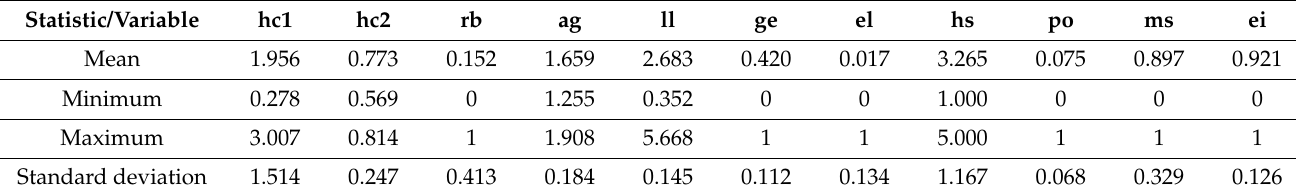
Table 2. Results of basic characteristic description of